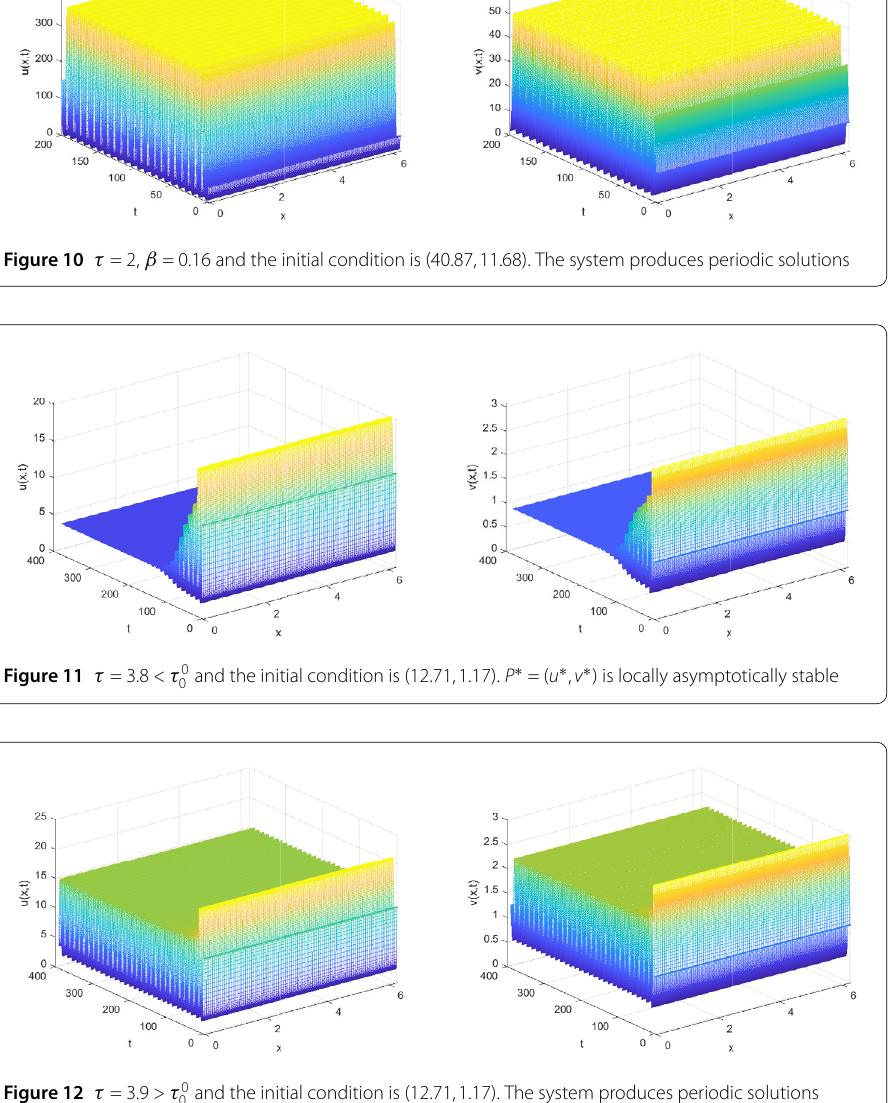
Figure 12 τ = 3.9 > τ 0 0 and the initial condition is (12.71,1.17). The system produces periodic solutions